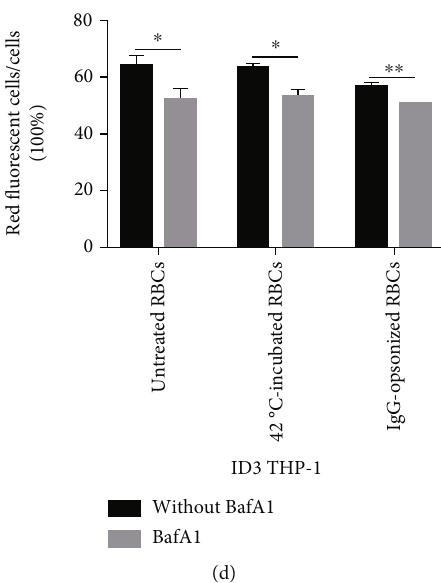
Figure 4: Autophagy of THP-1 caused by engul fi ng RBCs is inhibited by the autophagy inhibitor bafromycin. (a) Merge photograph of THP-1 cells stably expresses the mRFP-GFP-LC3 fusion protein after di ff erent stimulations. The above column shows the imaging results of the fl uorescence inverted microscope (200 × ), whereas the below column indicates the results from the confocal microscope (1,000 × ). The method of image data analysis and processing is the same as that used in Figures 3(b) – 3(d). (b) – (d) Histograms of red cell rates of three di ff erent THP-1 cells to the same RBCs with or without bafromycin. ∗ p < 0 : 05 , ∗∗ p < 0 : 01 , and ns: not signi fi